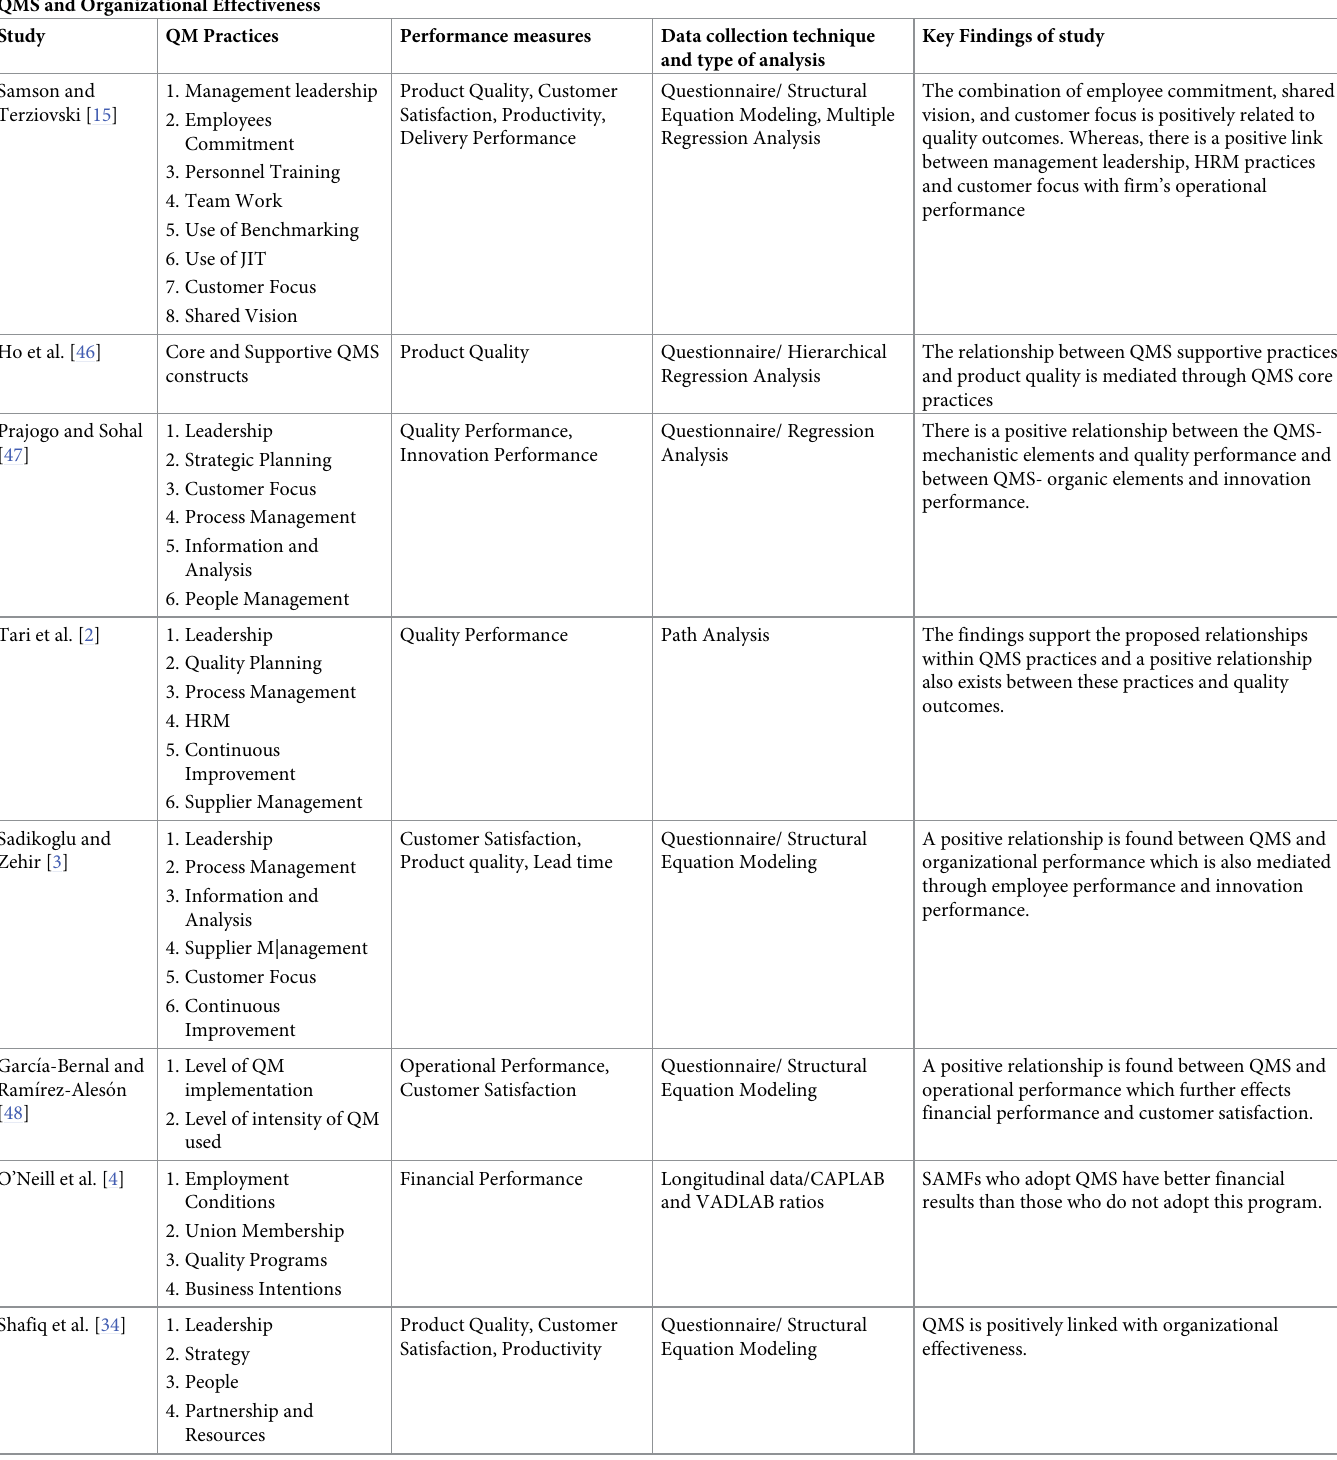
Table 1. Relationship of QMS and HPWS with organizational